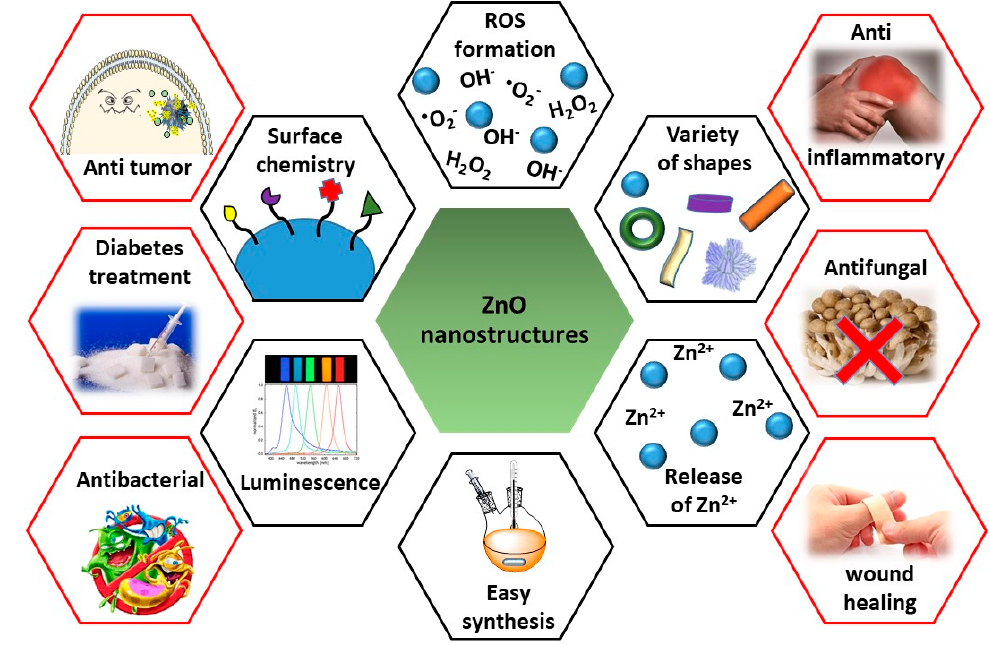
Figure 1. Diagram summarizing the main characteristics of ZnO nanostructures (black hexagons) and their principal applications in biomedicine (red hexagons).